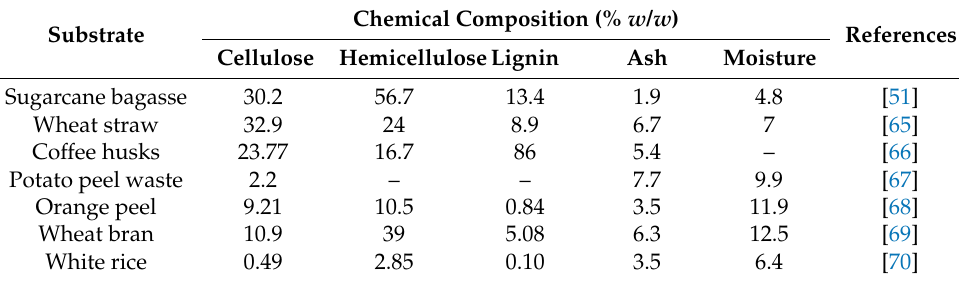
Table 11. Chemical composition of agro-industrial substrates used for SSF.